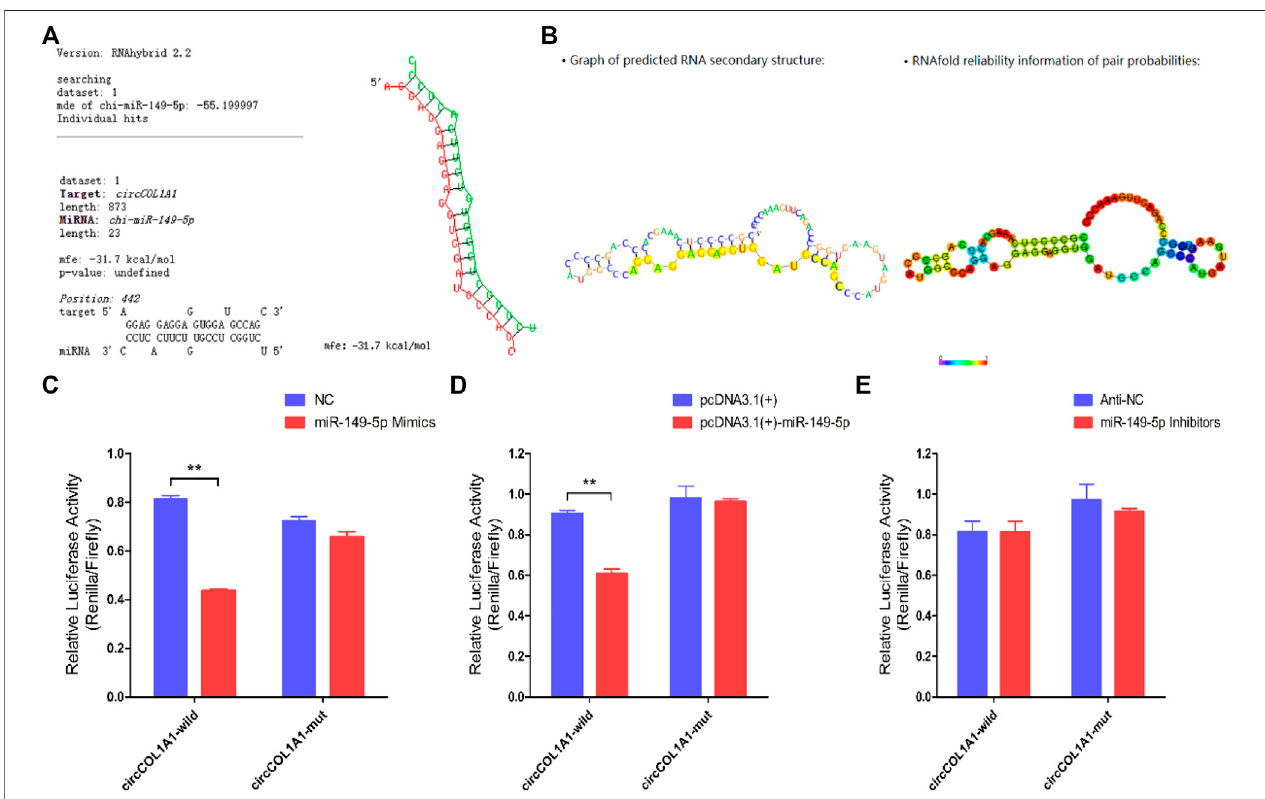
FIGURE 6 | CircCOL1A1 acts as a sponge for miR-149-5p in goat hair follicle stem cells. (A) The predicted circCOL1A1 binding site sequence on miR-149-5p usingRNAhybrid(v2.1.2)software. (B) ThepredictedsecondarystructureandbasepairprobabilitiesforcircCOL1A1andmiR-149-5pusingRegRNAv2.0software. (C) miR-149-5p mimics were co-transfected with the circCOL1A1-wild-type or circCOL1A1-mut vector into HEK293T cells. (D) The pcDNA3.1 (+)-miR-149-5p plasmid was co-transfected with the circCOL1A1-wild-type or circCOL1A1-mut vector into HEK293T cells. (E) The miR-149-5p Inhibitors were co-transfected with the circCOL1A1-wild-type or circCOL1A1-mut vector into HEK293T cells. (F) A schematic diagram of the miR-149-5p biosensor structure. (G) The miR-149-5p biosensor was co-transfected with miR-149-5p mimics or circCOL1A1-overexpressing plasmid into 293T cells. (H) Fold enrichment of circCOL1A1 and miR-149-5p determined byRT-q-PCRfollowingtheRIPassaywithAgo-2andIgGantibodies(negativecontrol). (I) TheexpressionofmiR-149-5paftercircCOL1A1overexpressionandinhibition using the RT-q-PCR assay. (J) Expression abundance of circCOL1A1, miR-149-5p, and CMTM3 in cervical spine skin tissues from NQ and SQ